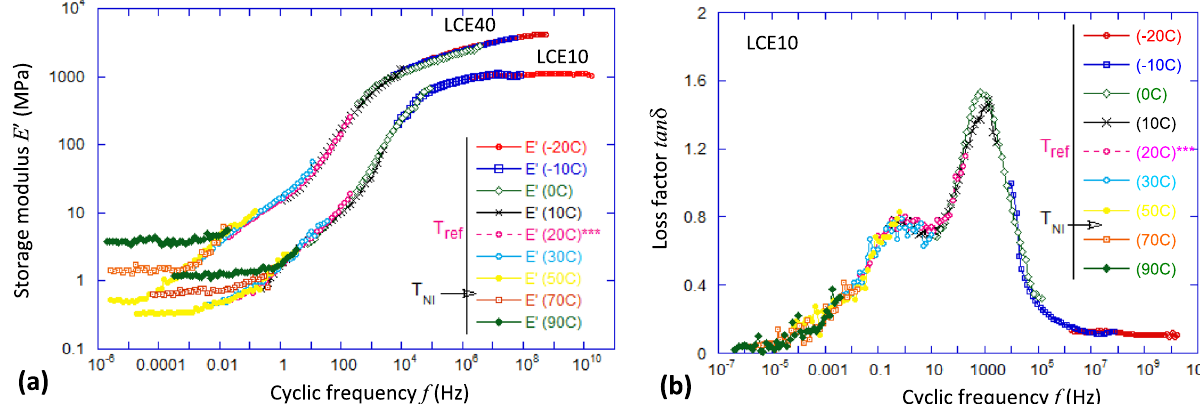
Fig. 2 Master Curves of LCE materials. a The tensile storage modulus E ′ ( ω ) for LCE10 and LCE40 materials, obtained by time – temperature superposition of frequency-scan tests at different temperatures (labelled in the plot) with the frequency scaled for the reference T = 20 °C. The nematic transition T NI for both materials is between 50 and 70 °C and indicates the end of dynamic softness (the isotropic rubber modulus increases on heating). b The corresponding Master Curve of the loss factor tan δ for LCE10, with the frequency scaled for the same reference T = 20 °C. Unlike the storage modulus E ′ , whose magnitude at high temperatures is affected by the nematic-isotropic phase transition and the entropic rubber elasticity, the time – temperature superposition for the loss factor works well at this high-temperature/low-frequency